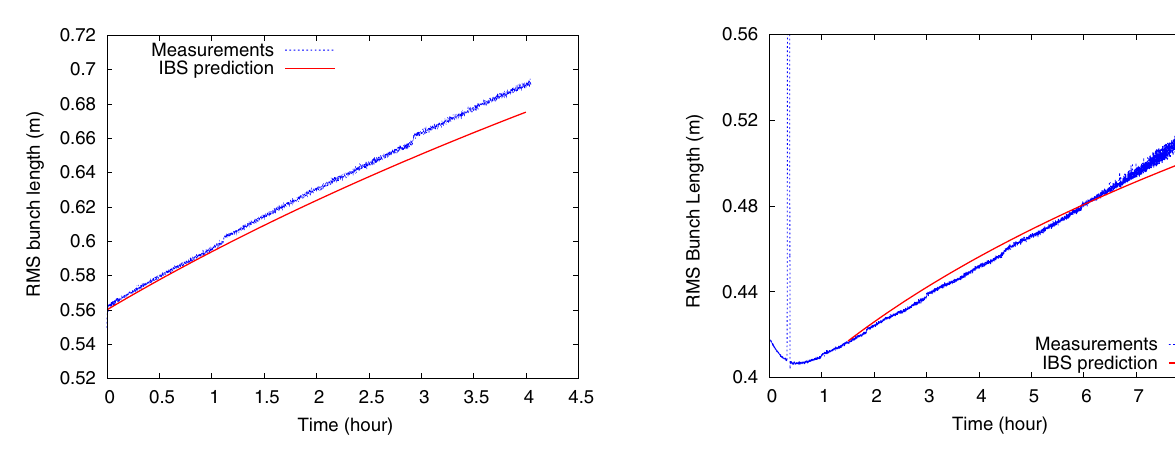
FIG. 13. Numerical modeling of bunch length growth without collision at store. Initial beam parameters similar to Fill 16697 are